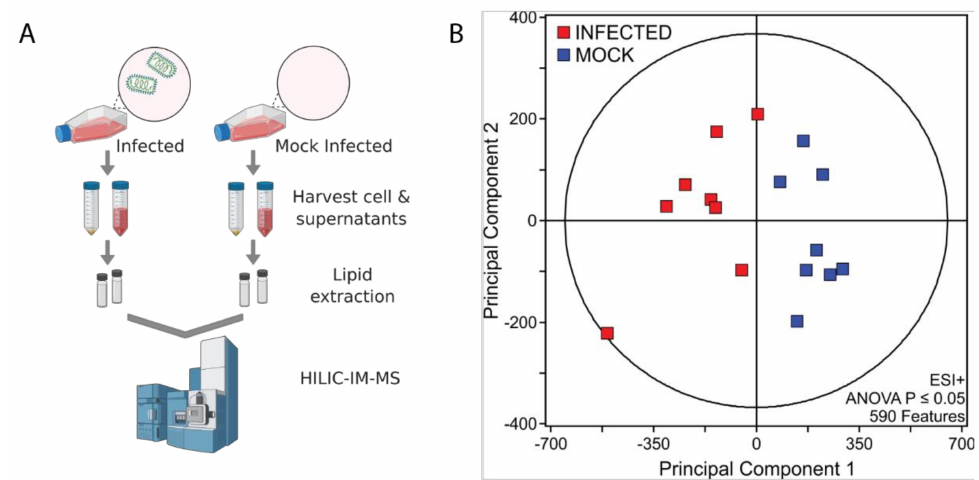
Figure 1. HILIC-IM-MS lipidomic profiling. ( A ) Depiction of workflow. Created in BioRender.com; ( B ) Data sets comparing mock-infected and infected cells were filtered by ANOVA p -value ≤ 0.05. Of the significantly altered features, a total of 101 lipid species were identified using the LipidMaps CompDB tool. Putative lipid IDs were evaluated alongside the HILIC retention times and the data-independent MS/MS spectra in the negative mode to confirm lipid class and fatty acyl composition, respectively (Figure 2A). Ion mobility extracted ion chromatograms of mock- and VSV-infected cells depict peaks corresponding to the major lipid classes that were identified (Figure 2A). Integration of chromatographic peak areas shows that there are similar proportions of lipid classes in both mock- and VSV-infected cell lysates (Figure